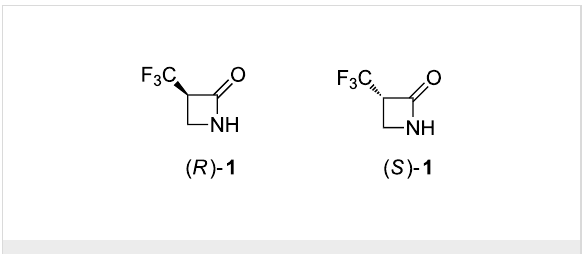
Figure 1: Enantiomers of α -(trifluoromethyl)- β -lactam ( 1 ).